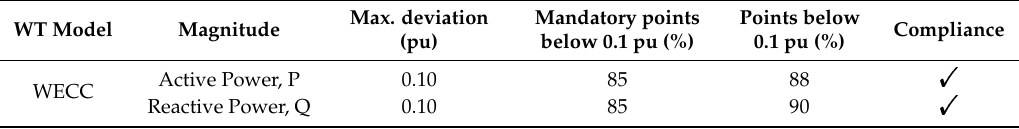
Table 4. Verification of the PVVC validation criteria applied to the WECC WT model at the LV measurement point, operating at partial load conditions: 690